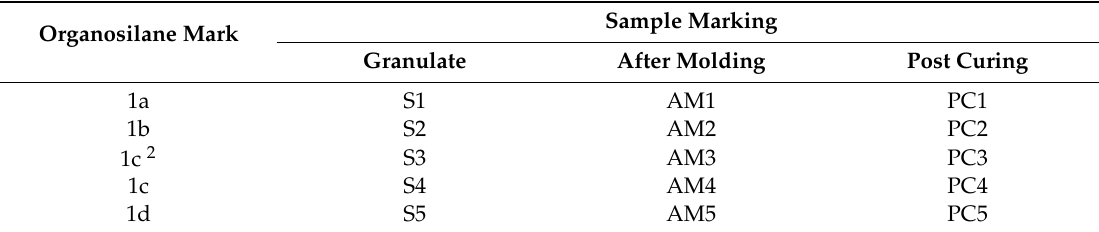
Table 2. Sample markings in regard to applied organosilane coupling agents.